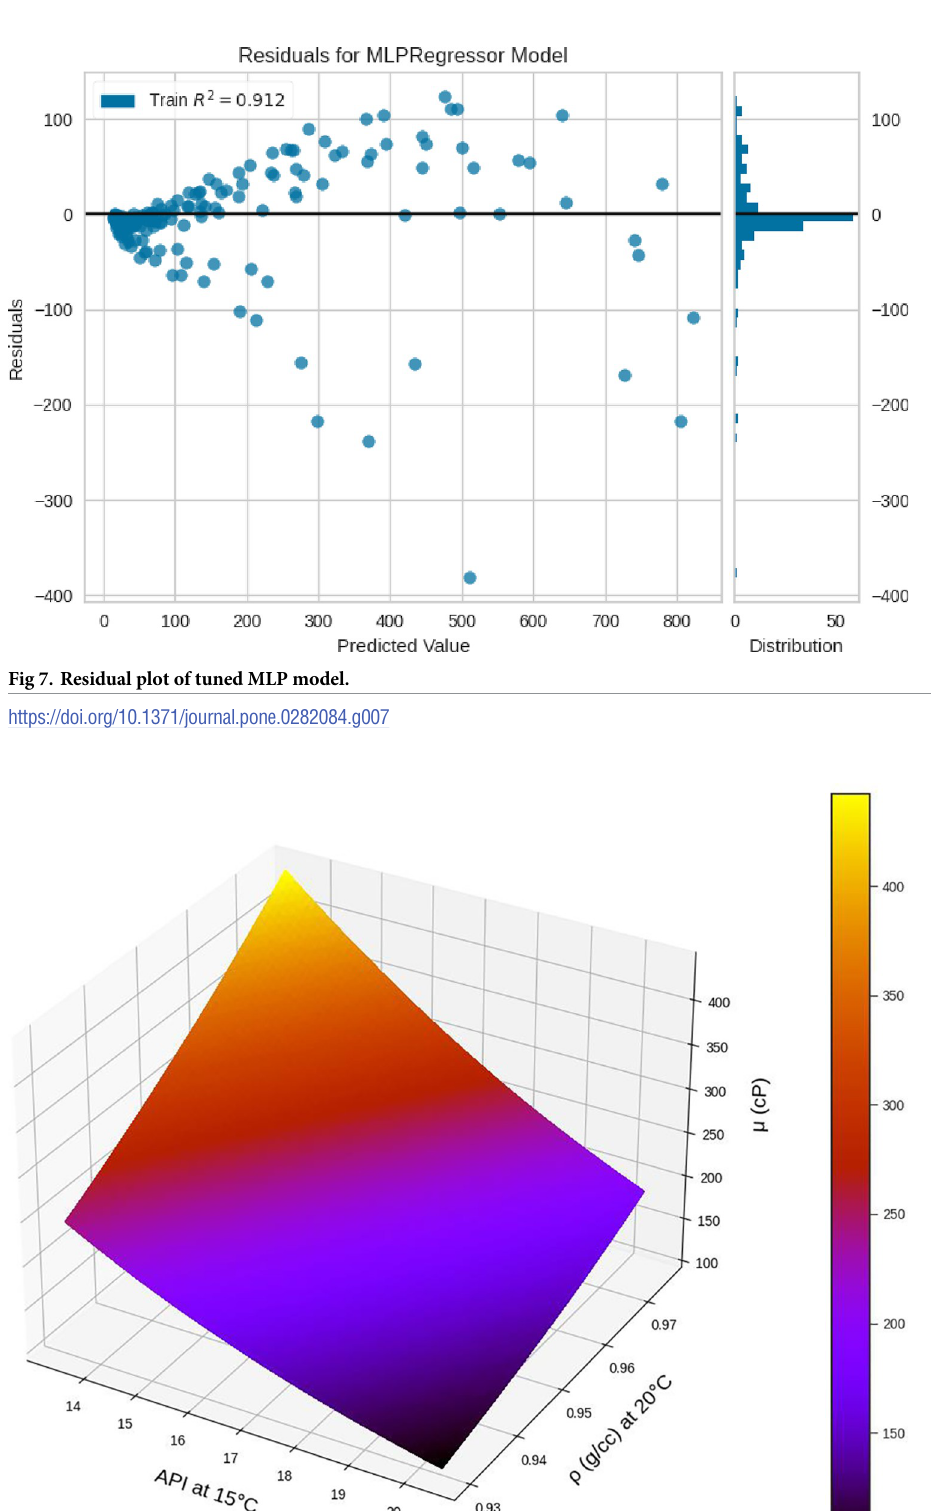
PLOS ONE | https://doi.org/10.1371/journal.pone.0282084 February 17,